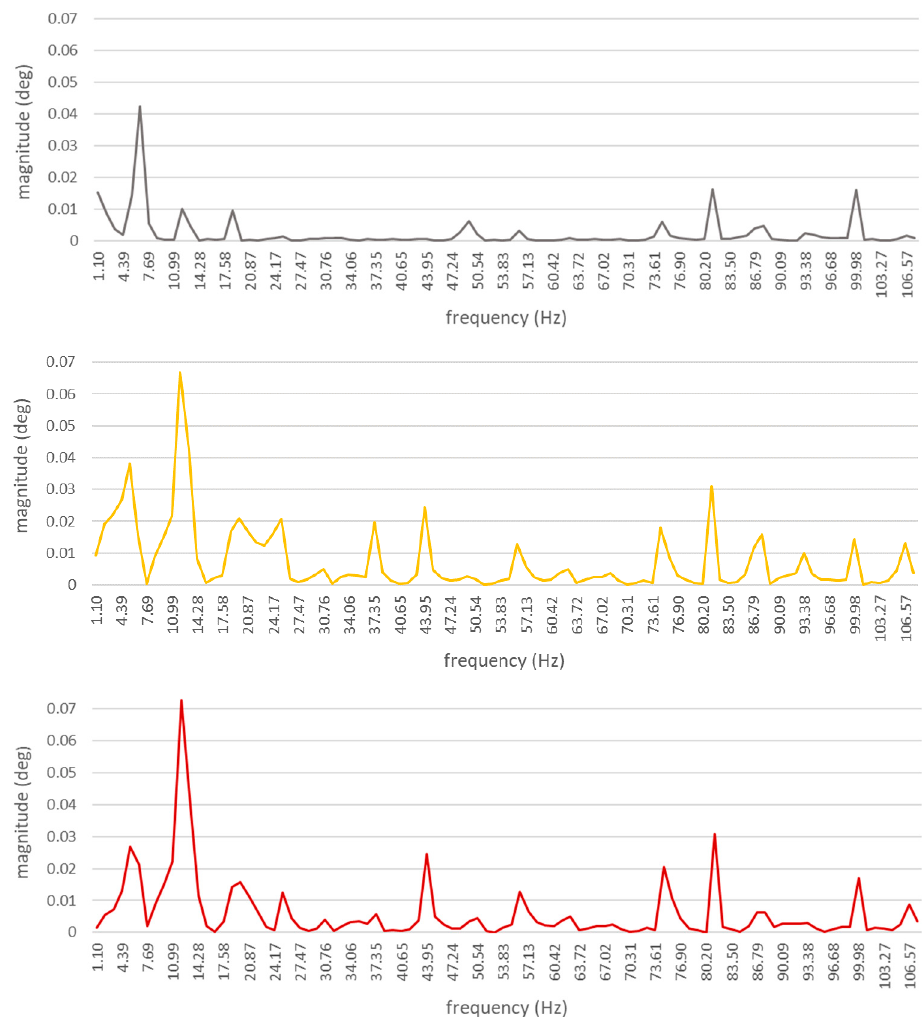
Figure 13. Absolute values of differences in the spectra related to a diesel–electric unit with a defect-free engine and with a defective injector nozzle. The diagram is limited to the 16th harmonic component only. Waveforms for: differences between defect-free and first coked; differences between defect-free and second coked; differences between defect-free and third coked.